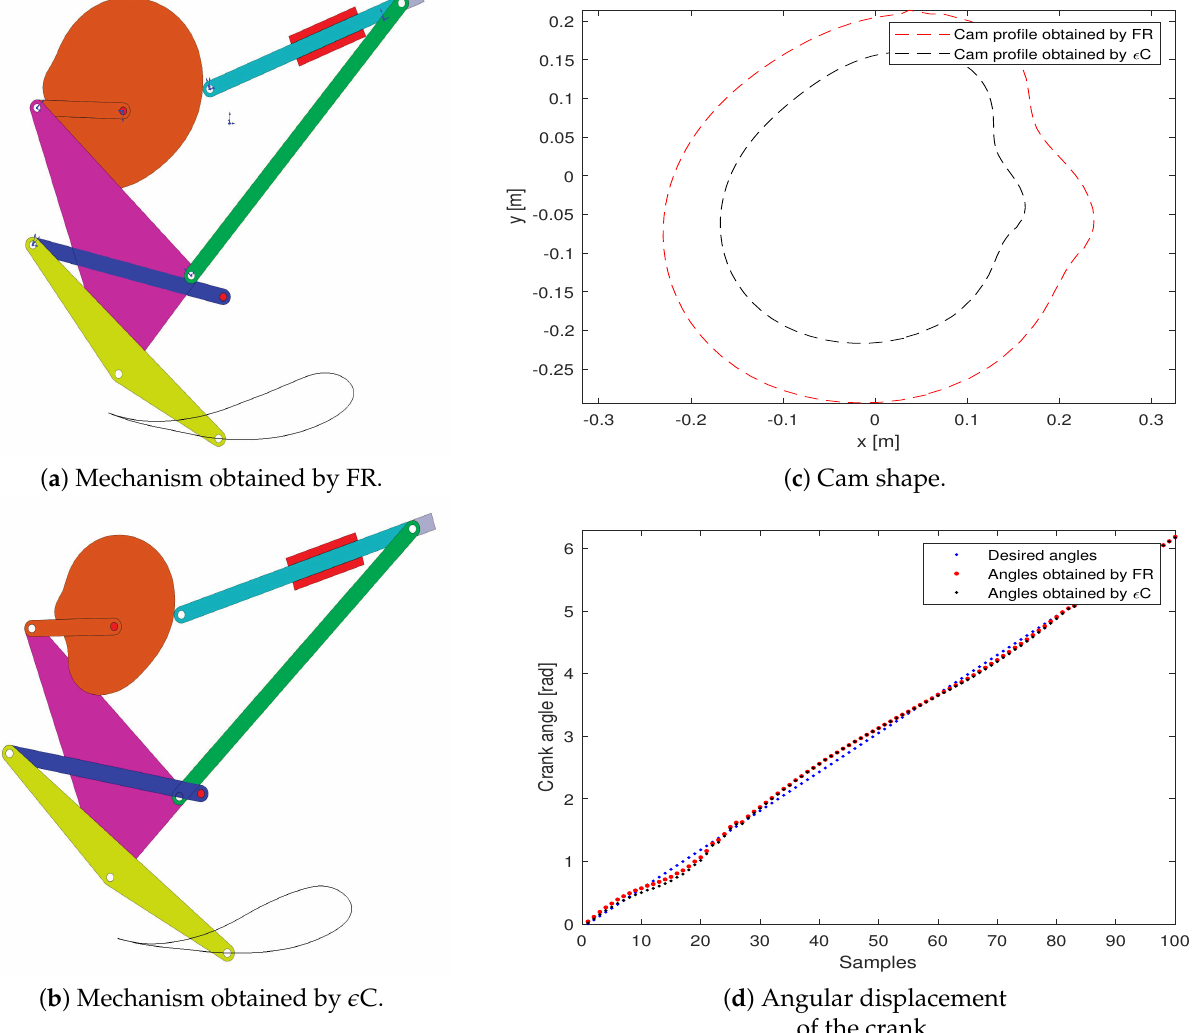
Figure 9. CAD representation and design goals of the mechanism (related to the terms ¯ J 1 and ¯ J 2 ) given by the best and the worst constraint-handling technique for solving study case